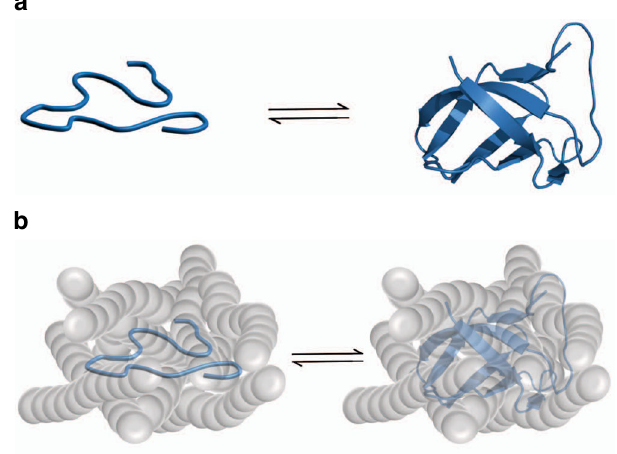
Fig. 1 Probing folding-to-unfolding equilibrium of Bs CspB at different conditions. The application of dilute conditions is shown in a whereas the presence of macromolecular crowding agents is highlighted in b by using ellipsoids colored in gray. The PDB ID 1NMG has been used to illustrate the protein backbone of Bs CspB representing the native state (right). One structure indicating the unfolded protein ensemble of Bs CspB has been modeled